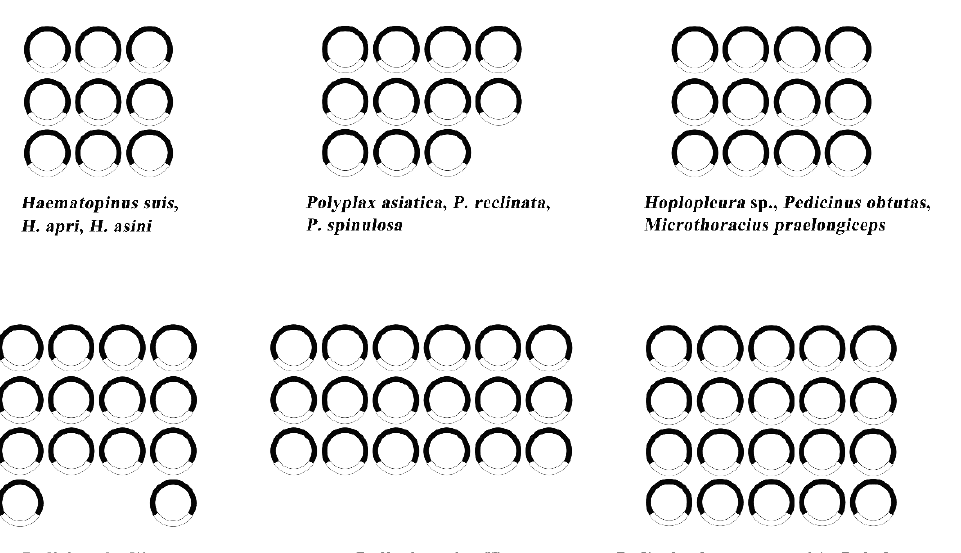
Figure 2. Numbers of mitochondrial minichromosomes of 12 sucking lice which all genes were identified in the mt genome.